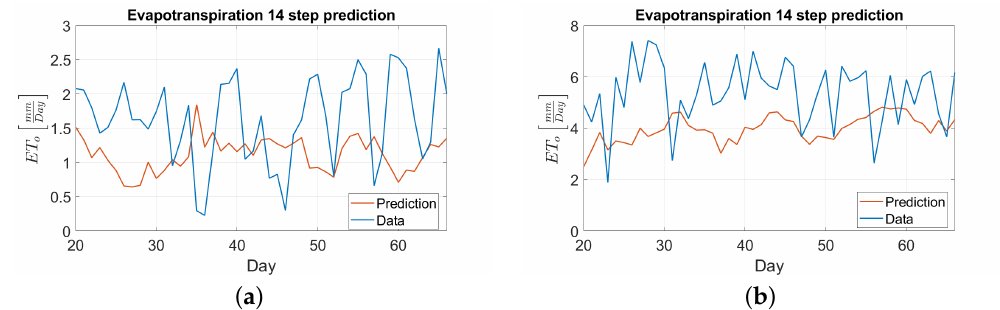
Figure 6. Comparison between the simulated evapotranspiration data and the corresponding predictions for both winter and summer. The simulated data are represented here by the blue line, and the red line shows the evapotranspiration output of the model. ( a ) Winter data for evapotranspiration ET o ; ( b ) summer data for evapotranspiration ET o